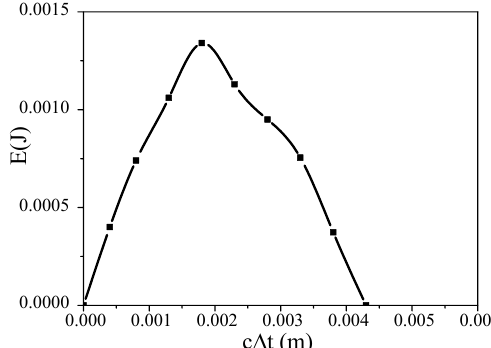
Figure 6. Intra-cavity radiation energy E(J) vs. time delay c ∆ t (m) between electrons and radiation for radiation wavelength λ = 15.2 µ m, emittance (cid:101) = 1 mm mrad, loss =